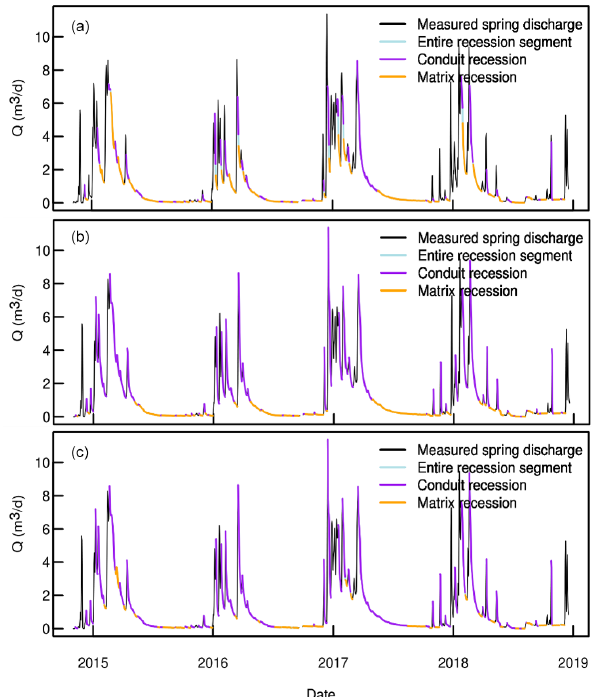
Figure A5. Qachquoch spring discharge hydrograph and extracted recession events recognized by the three REMs: (a) Vogel, (b) Brut- seart, and (c)